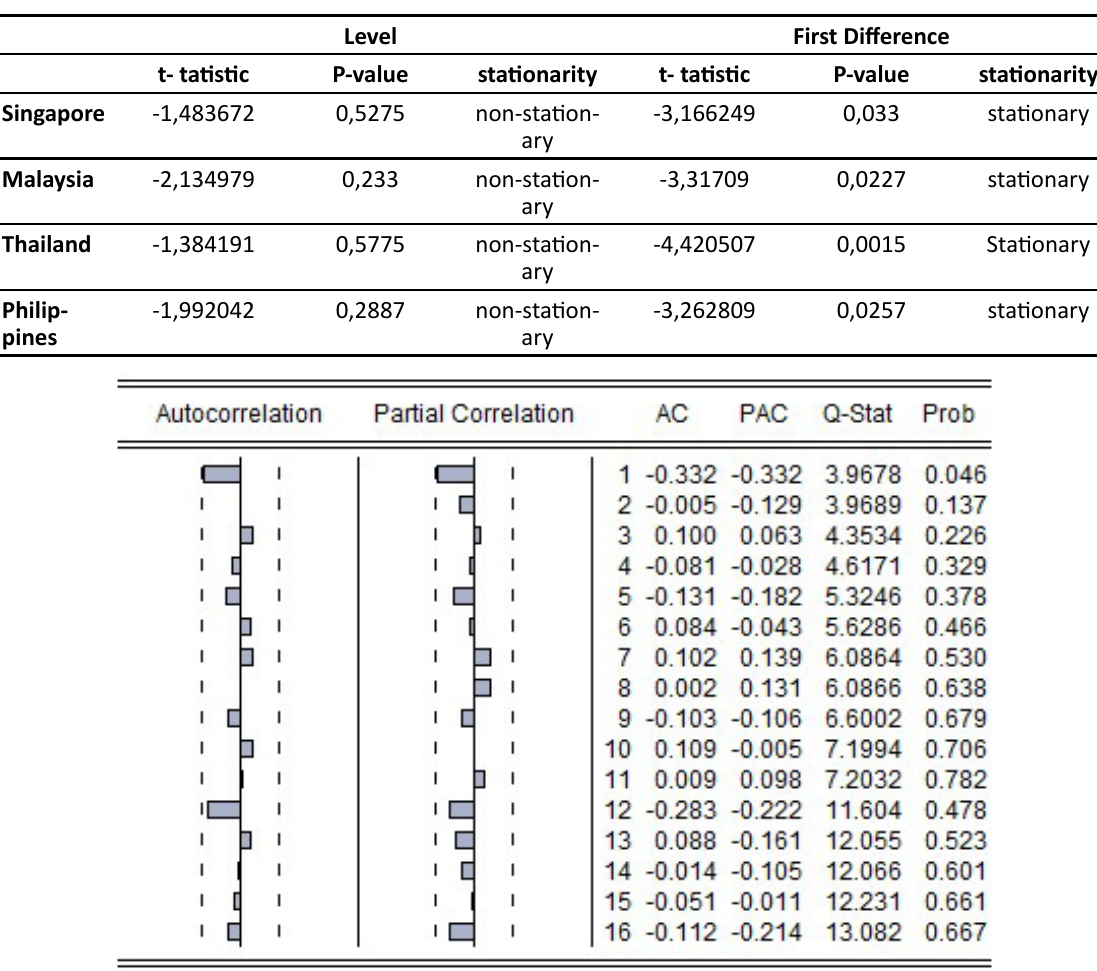
Figure 6: Correlogram of